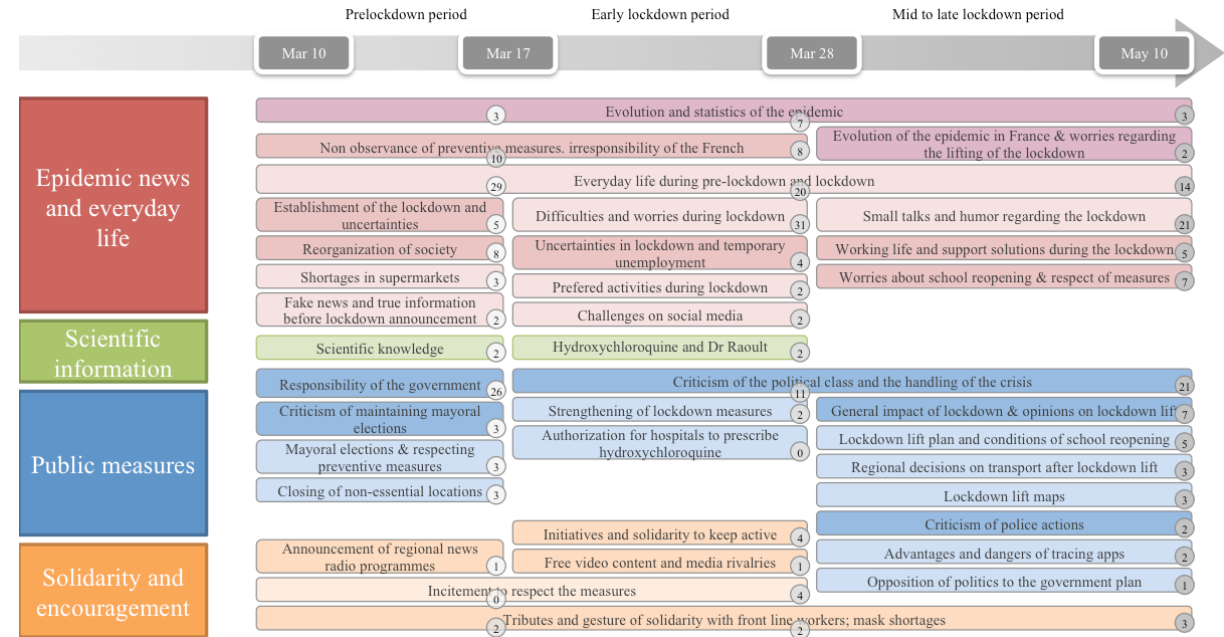
Figure 3. Topics identified on Twitter during the three periods. All topics are colored according to the category and aligned for the three periods. The factual topics are colored in dark red and dark blue, and the subjective topics are colored in light red and light blue for the first and the third category, respectively. The percentage of each topic is indicated in a circle at the bottom